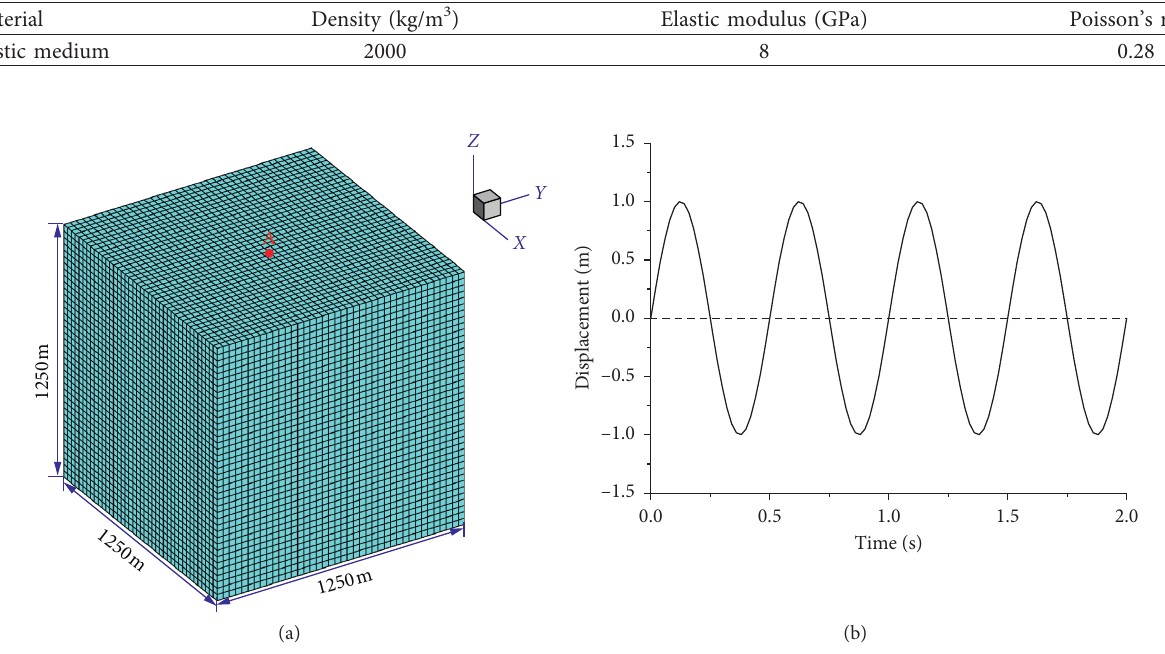
Figure 7: (a) 3D Finite element model and (b) incident waves for numerical